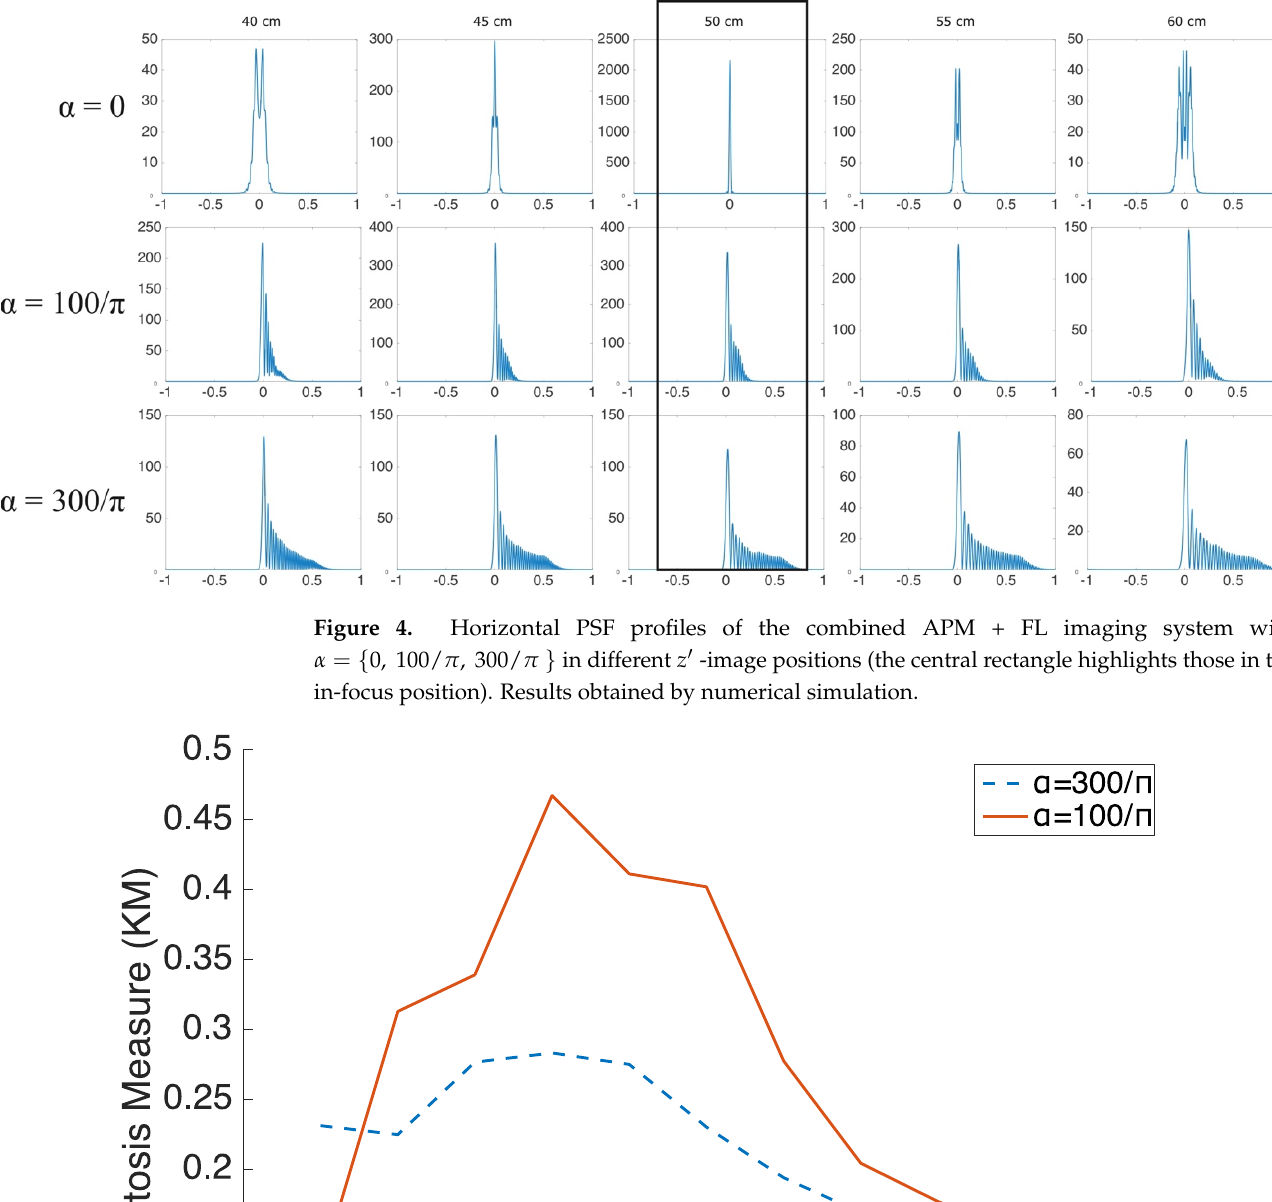
Figure 6. Numerical simulation of the PSFs (top) and the images of the extended object (bottom) for the combined APM + FL imaging system with the optimized value 𝛼 = 100 𝜋⁄ along the z’-image plane range (rectangle in the in-focus position). The pupil size was L = 8.64 mm. Figure 7. Experimental results of the PSFs (top) and the images of the extended object (bottom) for the combined APM + FL imaging system with the optimized value 𝛼 = 100 𝜋⁄ along the z’-image plane range (rectangle in the in-focus position) obtained with the optical setup depicted in Figure 1. The pupil size was L = 8.64 mm.